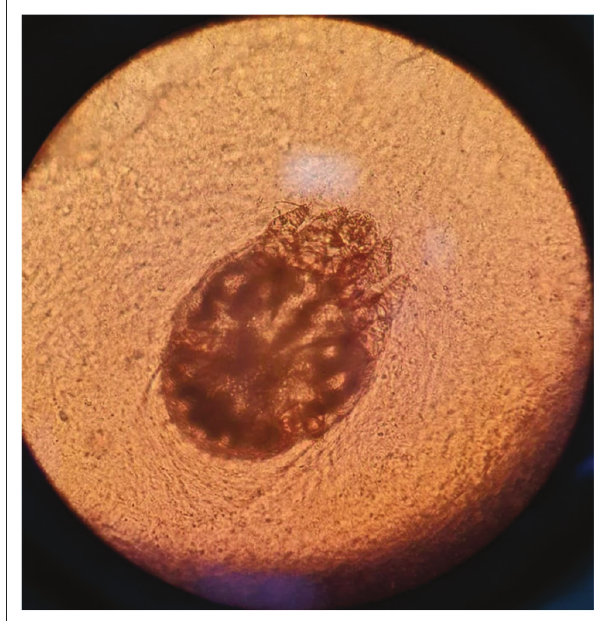
FIGURE 3: Ova of Sarcoptes scabiei on potassium hydroxide preparation. FIGURE 4: Sarcoptes scabiei mite on potassium hydroxide